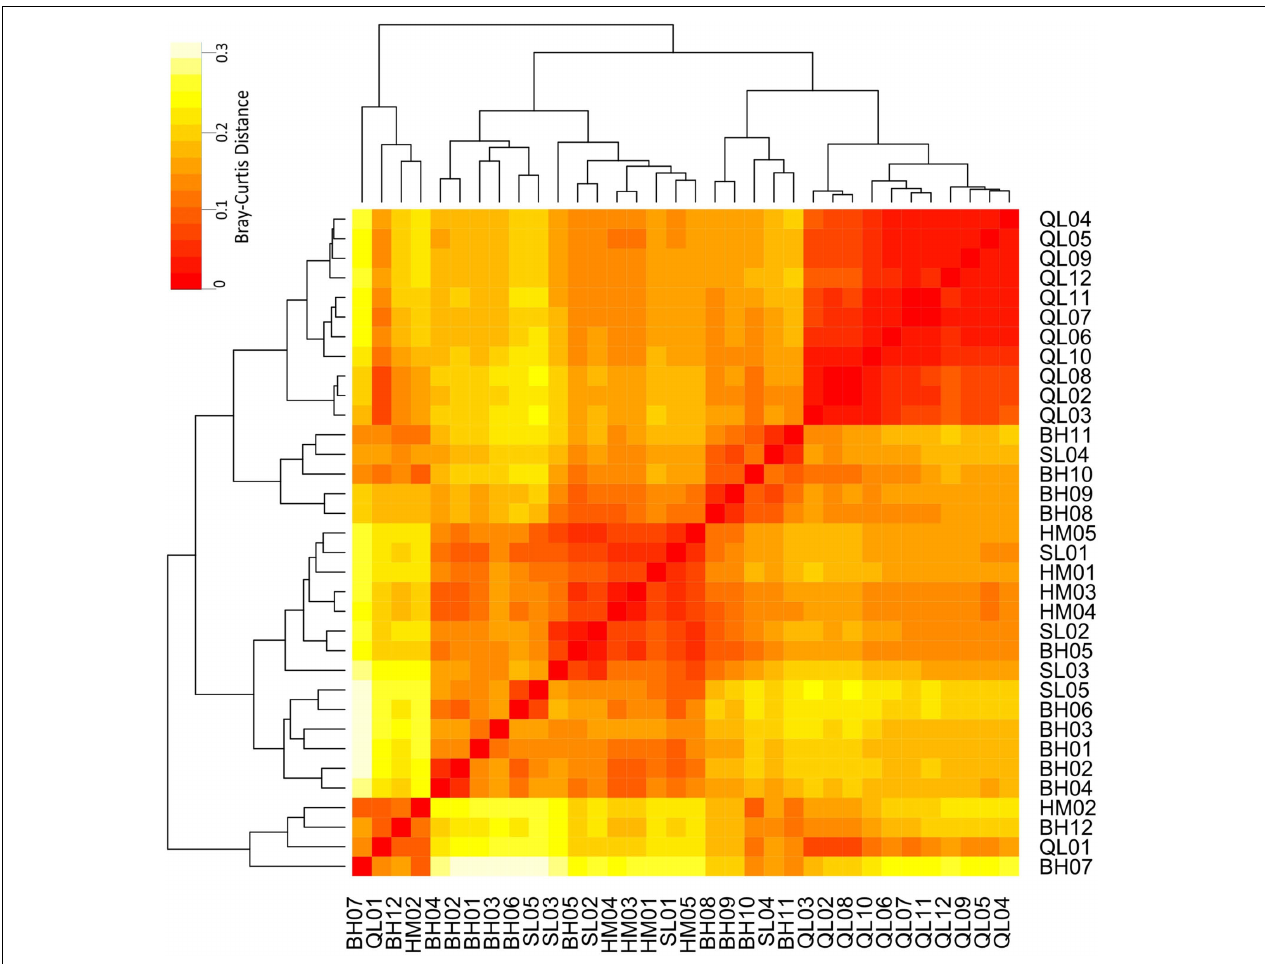
FIGURE 4 | Heatmap showing the functional differences of microbial communities between streams and Qinghai Lake based on Bray–Curtis distance. Bray–Curtis distances were calculated using relative abundances of PICRUSt predicted KEGG orthologies